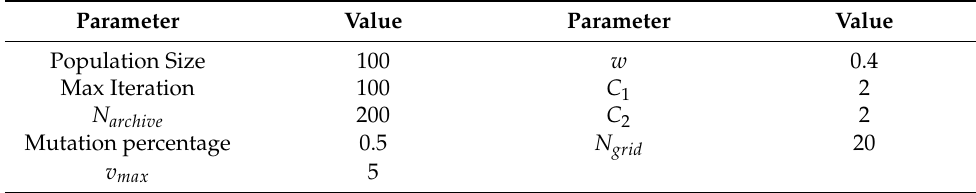
Table 5. MOPSO parameters.